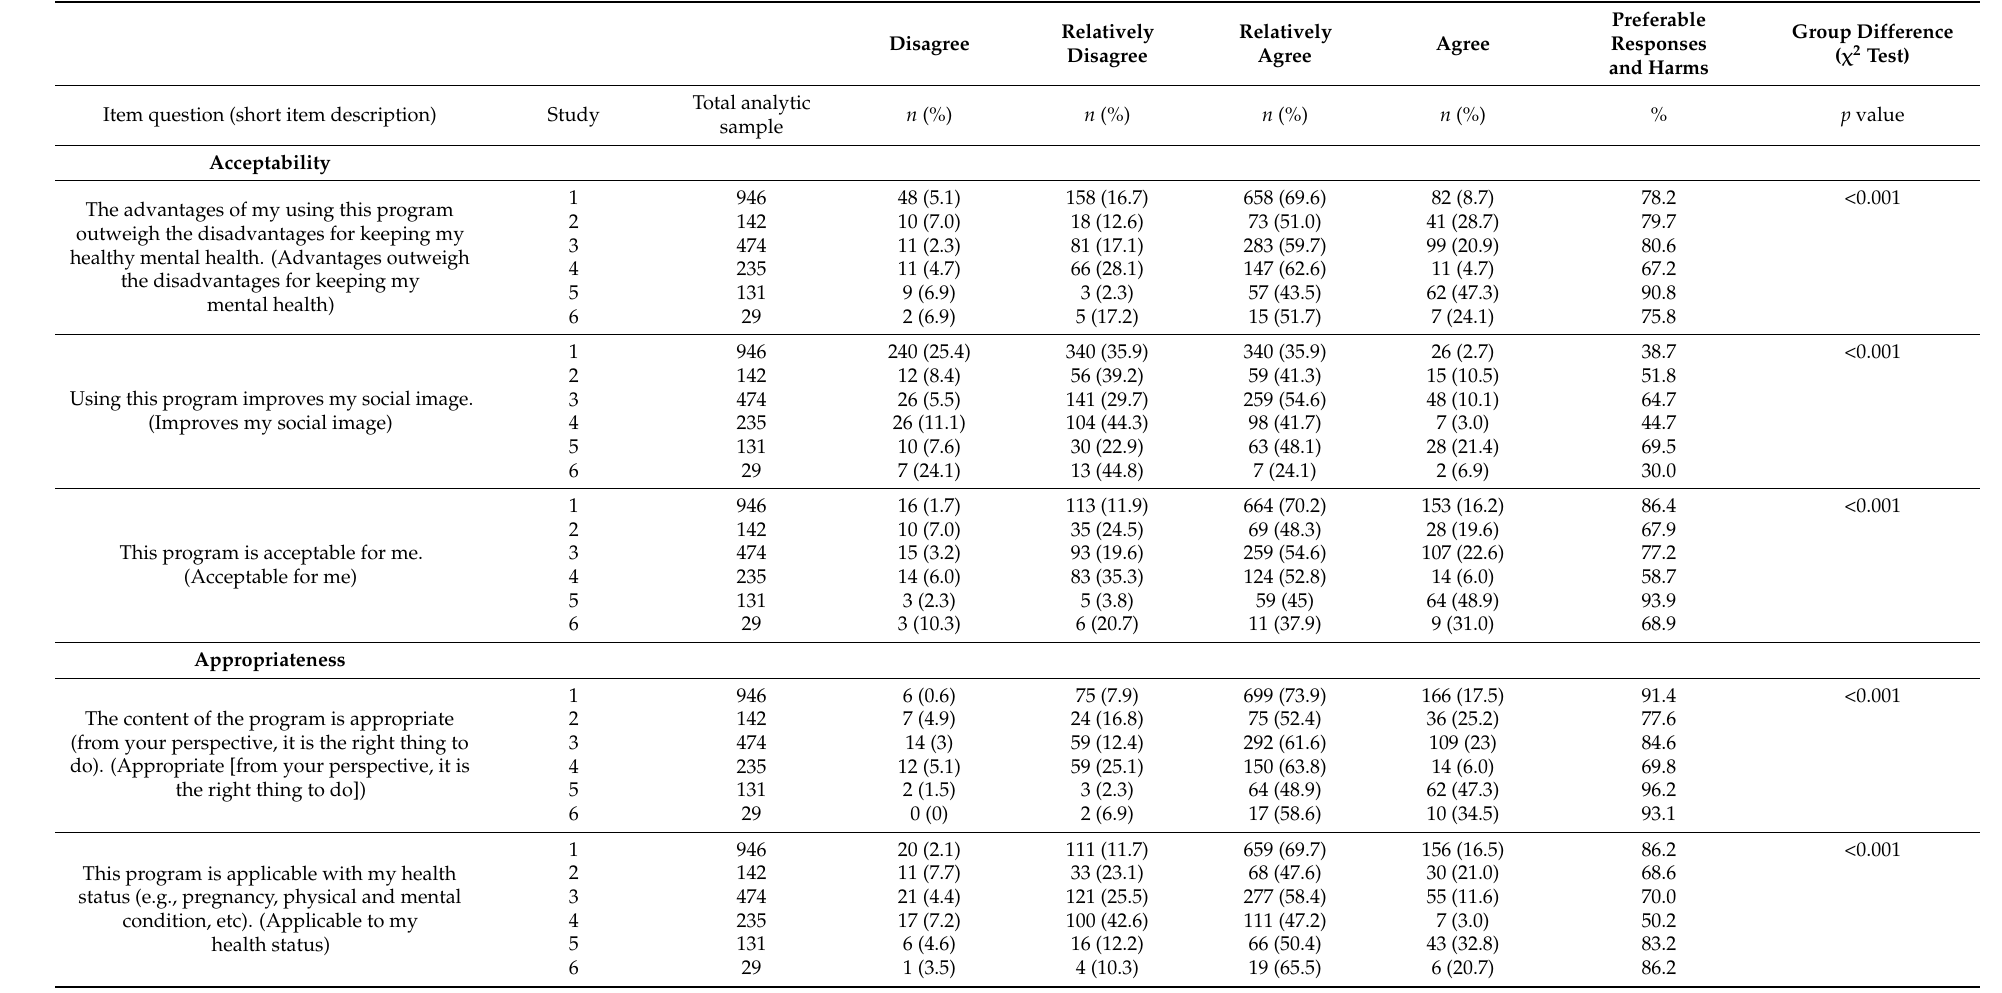
Table 2. iOSDMH Descriptive